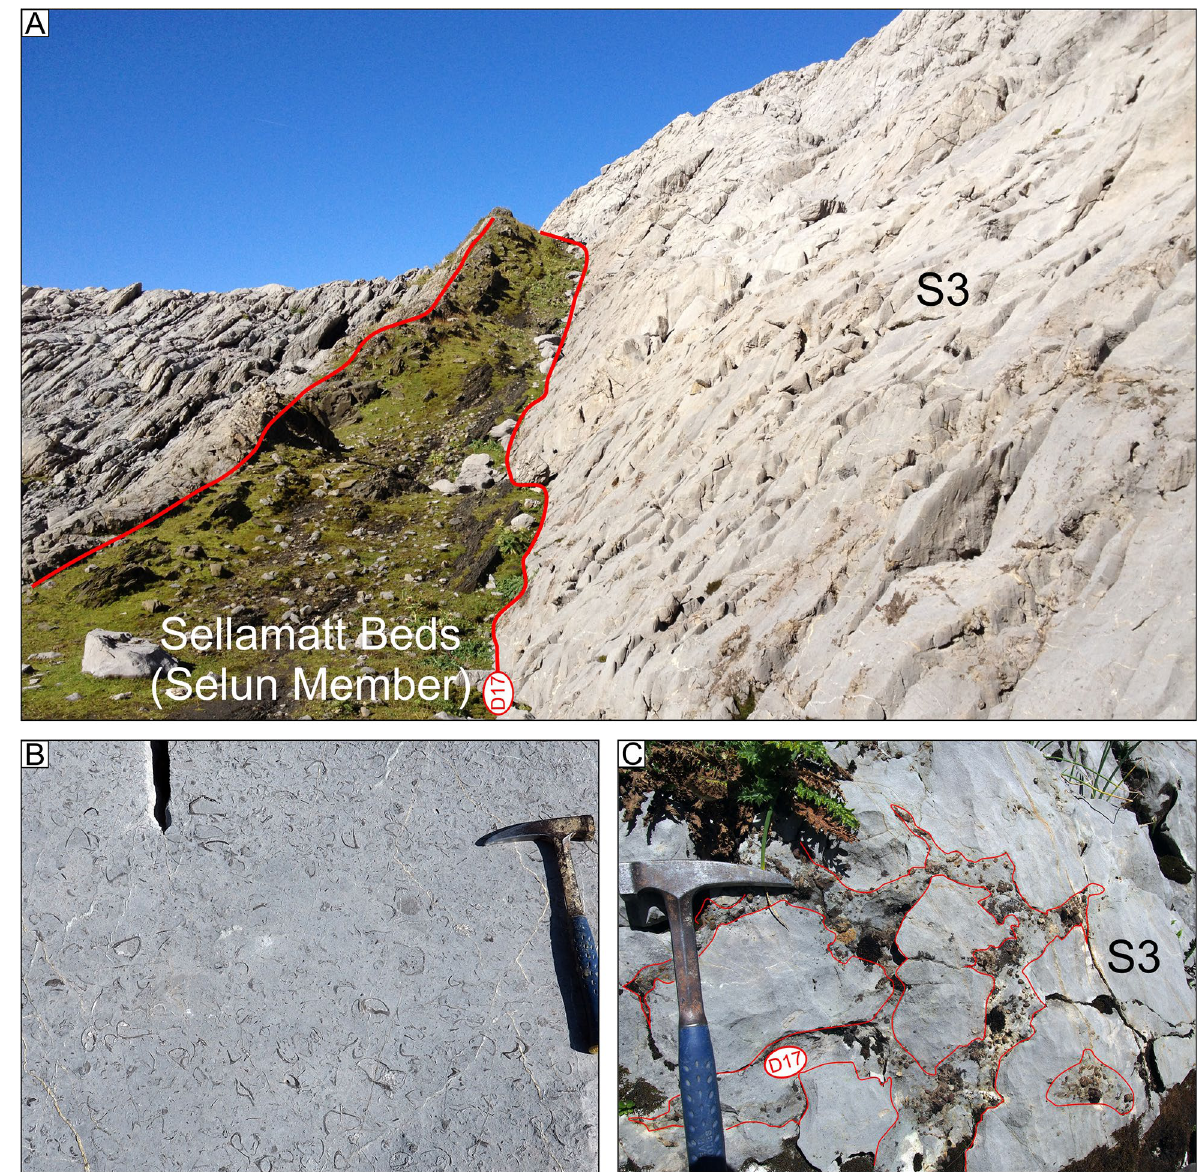
Fig. 7 A Overview in the Tierwis-Grauchopf section of the top of the Schrattenkalk Formation (unit S3) overlain by the Garschella Formation represented here by the Selun member. B View of the Requienidae-bearing beds of unit S3. C Focus on the irregular topography with epikarstic features on top of unit S3, filled with a phosphatic